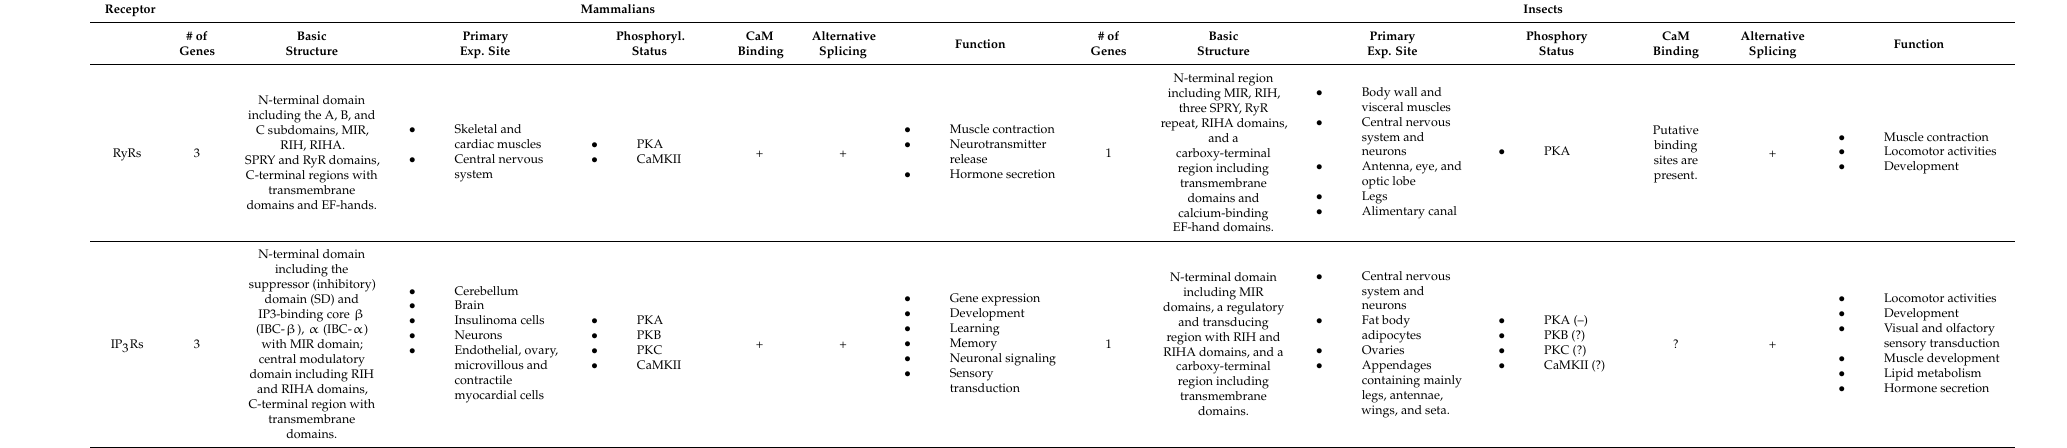
Table 2. Comparison of structural and functional features of mammalian and insect RyR and IP 3